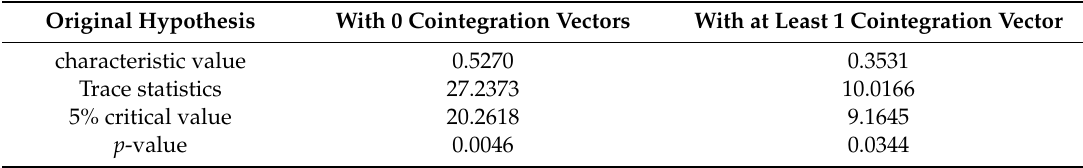
Table 5. Cointegration test results of